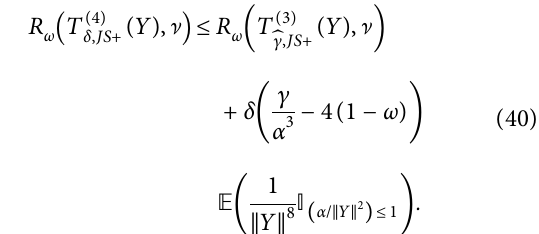
Figure 3: Curves of R ( Y, ] ) as functions of λ for d � 8 and ω � 0 . R ω